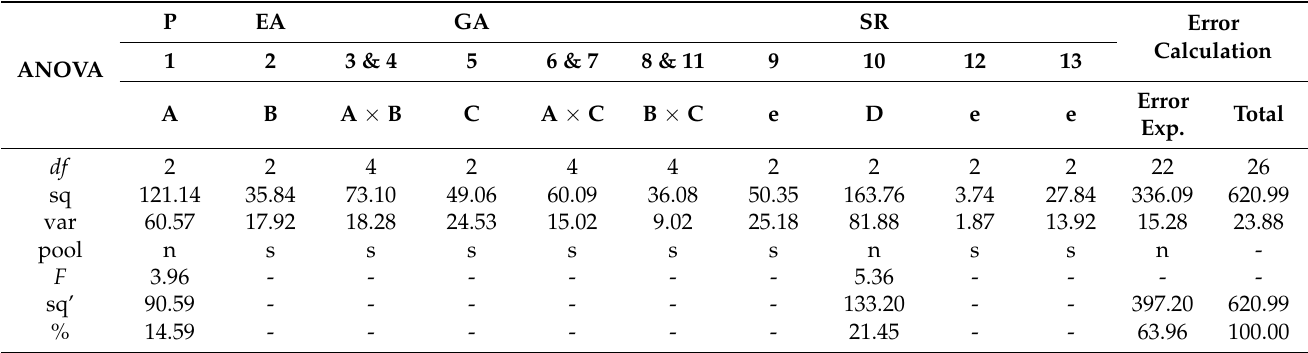
Table 6. ANOVA analysis.